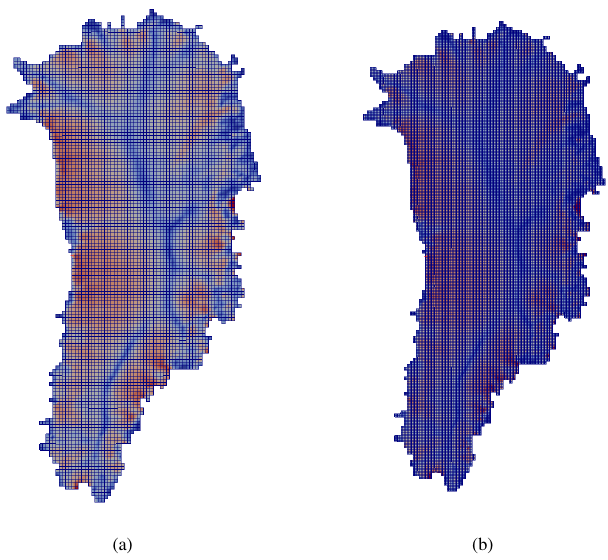
Figure 9. Examples of uniform mesh refinement: (a) no refinement (8km GIS), and (b) one level of refinement (4km GIS). Table 3. Formulas for different vertical mesh-spacing strategies (uniform vs. graded), for i = 0 ,...,n z